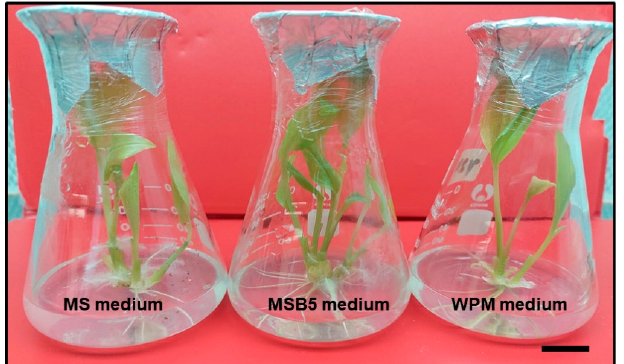
Figure 1. Establishment of C. caesia microshoots in MS medium, MSB5 medium and WPM medium after six weeks of inoculation. Scale bar represents 1 cm of actual size.